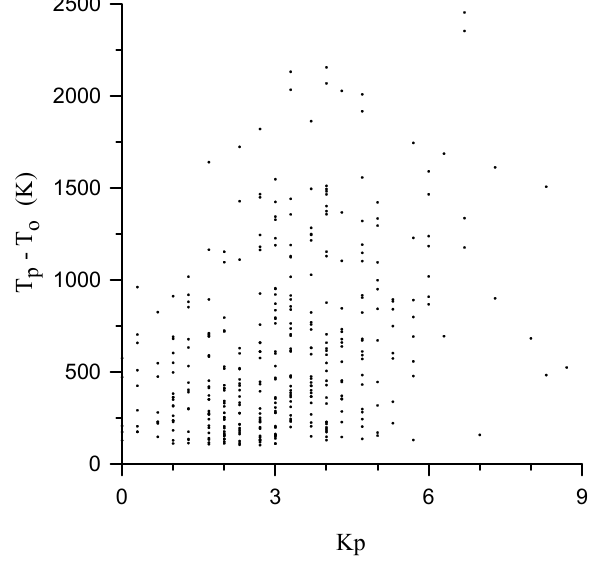
Fig. 9. The relationship between the measured electron temperature and number density changes at 400km during NETEs over Mill- stone Hill. The temperature changes are expressed as the difference between the temperature at the peak, T p , and the temperature at the onset, T o . The electron number density changes are the ratio of the electron number density at the peak electron temperature, N p , to the electron number density at the onset of the NETEs, N o